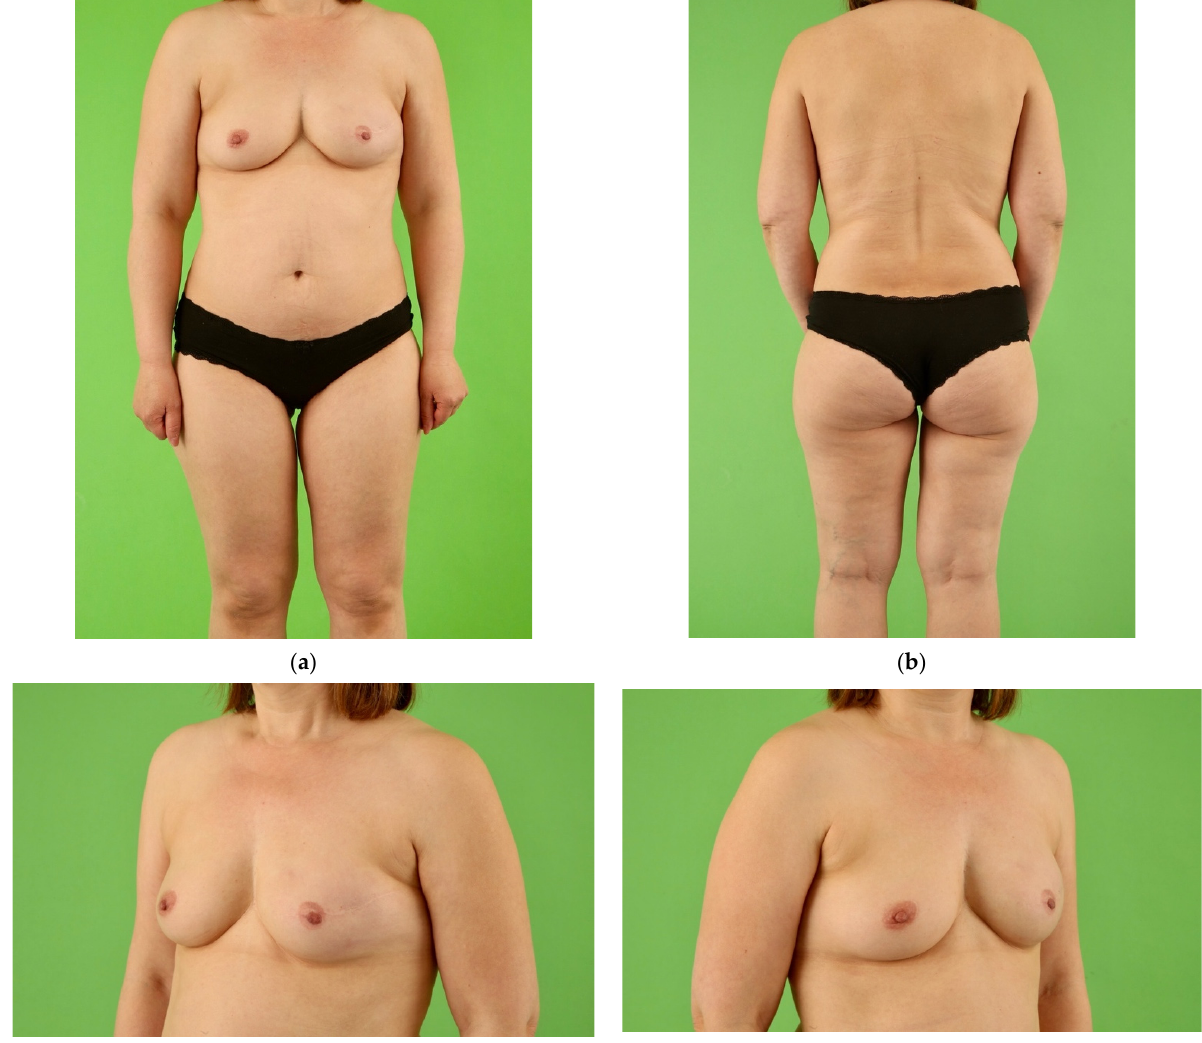
Figure 3. Normal-weight female patient (49 years, BMI 24.9 kg/m 2 ) with invasive ductal carcinoma on the left breast in the medical history. Salvage reconstruction of the left breast with unilateral TMG flap from the right thigh following implant failure and skin-sparing mastectomy of the left breast. One refinement procedure of lipofilling from the abdomen was performed for volume boost-up the left breast combined with excision of the TMG skin island. In a second procedure, unilateral nipple reconstruction was conducted with nipple-sharing. Postoperative view at 6.0 year follow-up. ( a ) Front view with natural symmetry of the thighs after unilateral TMG flap harvest from the right thigh and concealed donor site scar in the groin of the right thigh. Excellent symmetry of both breasts following TMG flap reconstruction of the left breast and natural right breast; ( b ) Back view with natural symmetry of the thighs and concealed donor site scar in the natural crease of the right buttock; ( c , d ) Natural shape with volume symmetry of both moderate size breasts following unilateral TMG flap reconstruction of the left breast.